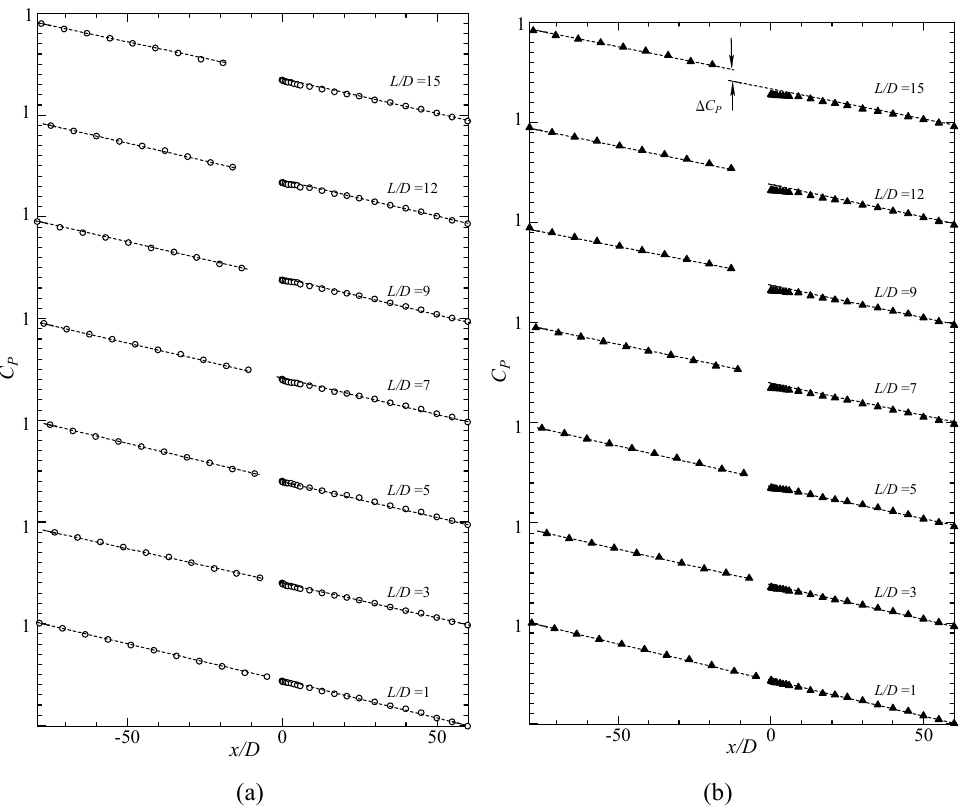
Fig. 4 Static pressure coefficient along the downstream of pipe flow; (a) d-type (b)